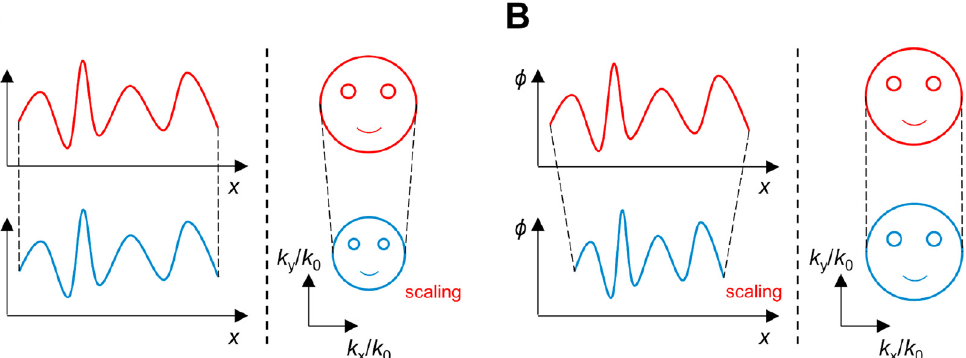
Figure14: Conceptofbroadbandhologram.(A)Dispersion-lessphasehologram.Blueandredcolorscorrespondtohighandlowfrequencies, respectively. Left figures show dispersion-less phase distributions over the spatial domain in which phase distributions for red and blue frequencies are identical. Right figures show resulting images in normalized spatial frequency domain. (B) Dispersion-less image hologram. Left figures show required phase distributions, which are scaled with respect to frequency, for images with identical size. Right figures show resulting dispersion-less images in normalized spatial frequency